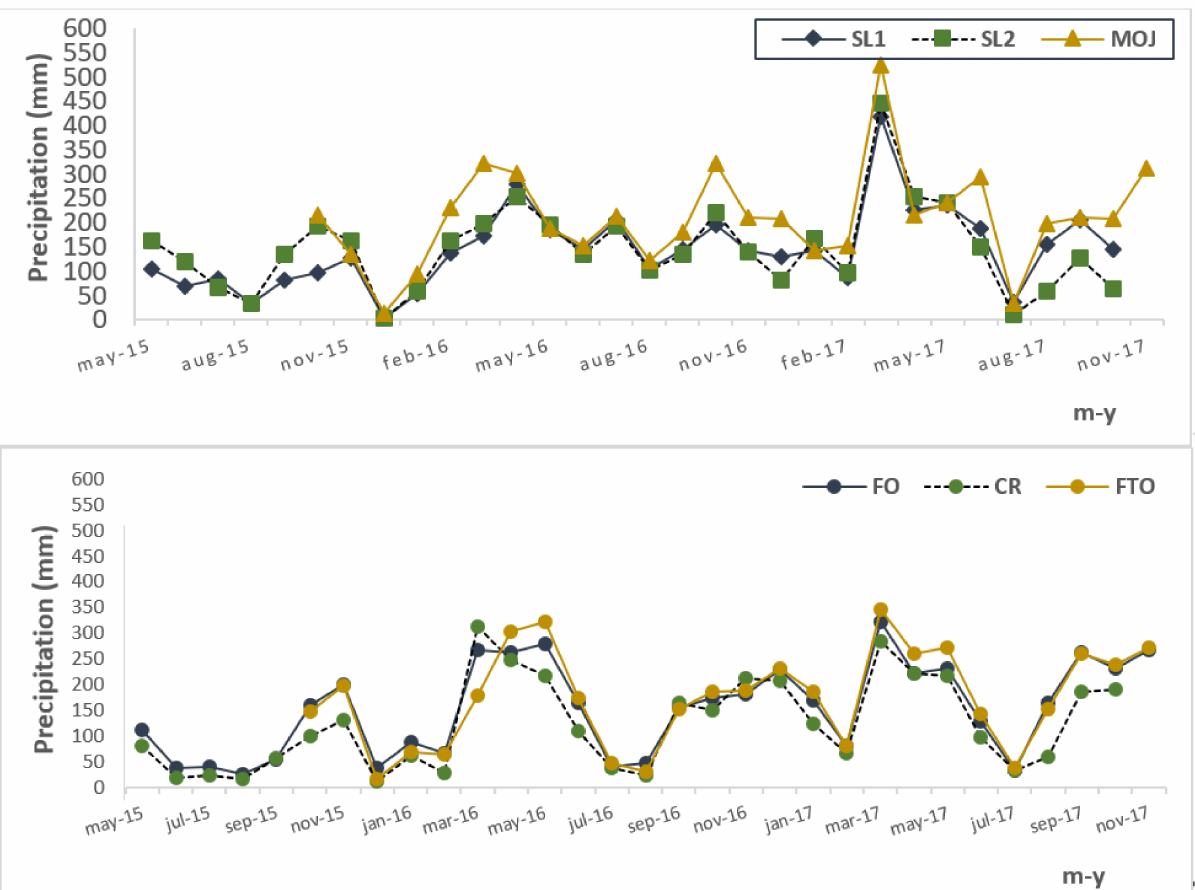
Figure 3. Monthly distribution of precipitation (May 2015–November 2017) on microbasins SL1, SL2, MOJ in the Combeima River basin ( up ), and FO, CR, FTO at the Cali River basin ( down